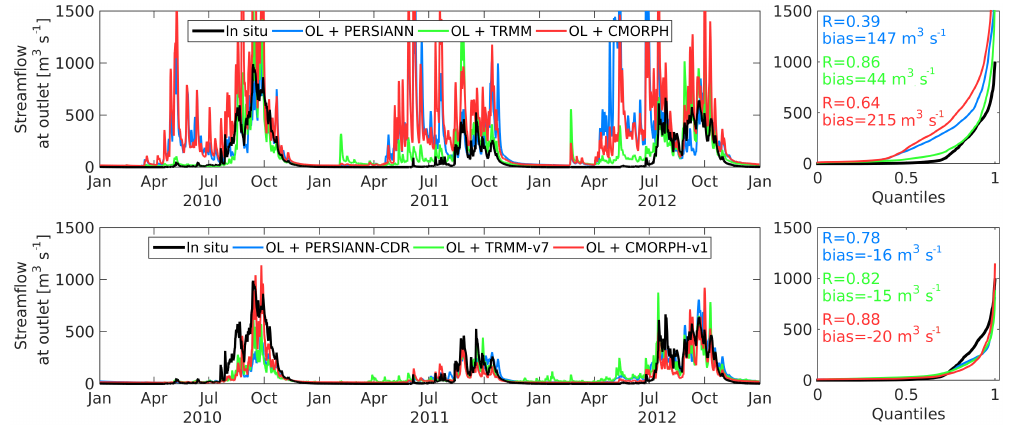
Figure 4. Open-loop (OL) streamflow simulations using the RT and reanalyzed satellite precipitation products as forcing. Statistics are given on the right panel. For comparison, the streamflow simulations using in situ precipitation as forcing (not shown here) lead to a correlation of 0.92 for a bias of 32m 3 s − 1